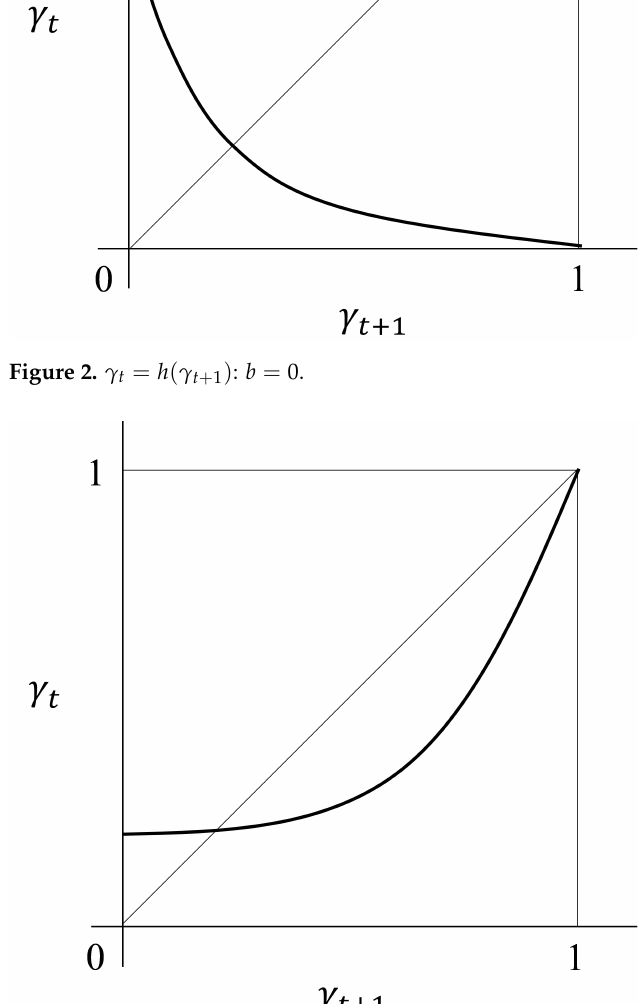
Figure 3. γ t = h ( γ t + 1 ) : a = 0, ρ =